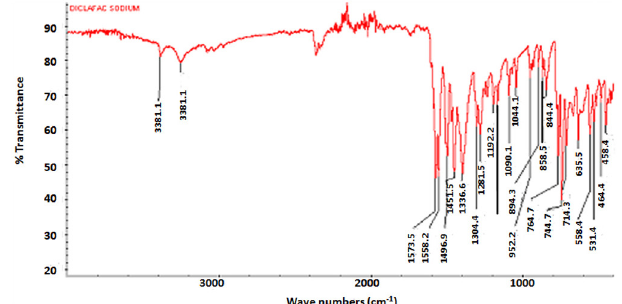
FIGURE 3 – FTIR spectrum sodium